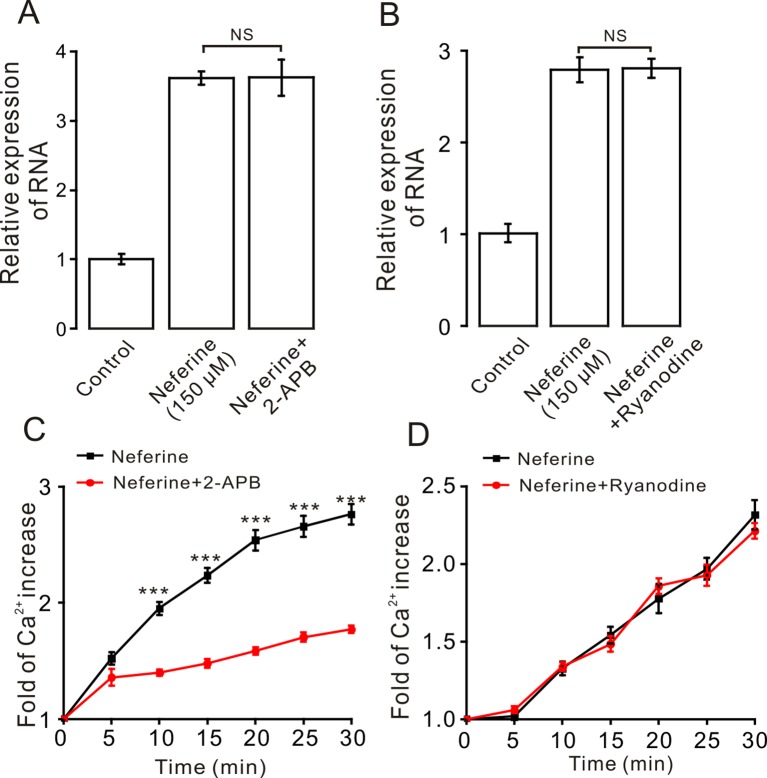
IP3R mediates neferine-triggered intracellular Ca2+ release. (A) Incubation of IP3R receptor blocker 2-APB (100 µM) for 30 min has no effect on neferine-induced GLUT4 mRNA expression. (B) Incubation of ryanodine (RyR blocker, 30 µM) for 3 h has no effect on neferine-enhanced GLUT4 expression. (C) 2-APB inhibits the increase in Ca2+ concentration. (D) Neferine-stimulated intracellular Ca2+ concentration was not inhibited by Ryanodine. NS P > 0.05; ***P < 0.001.